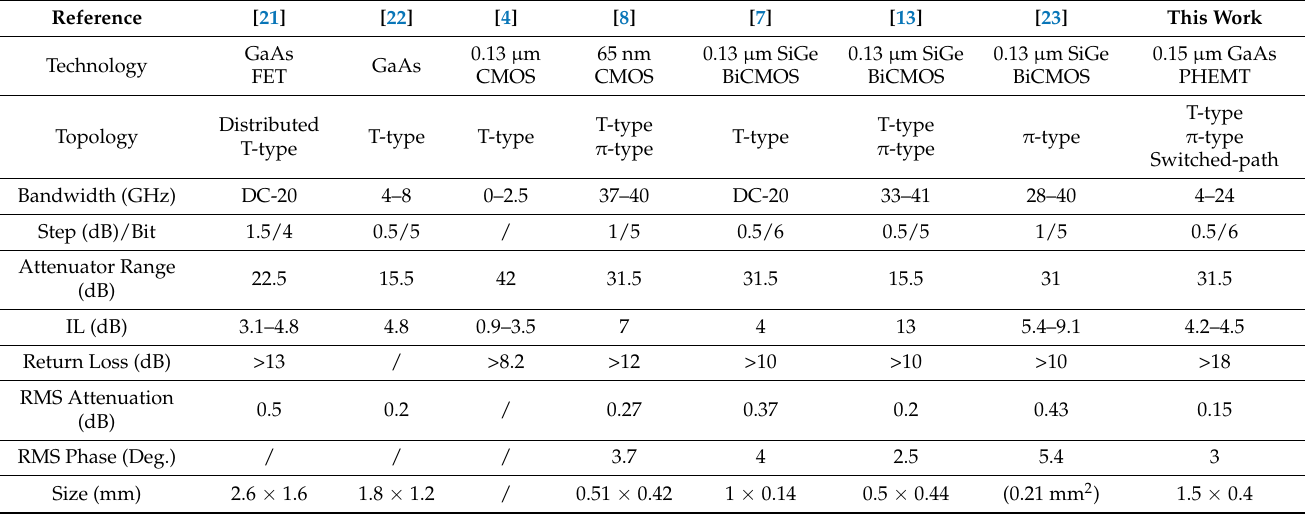
Table 1. Performance comparison with state-of-the-art DSAs.